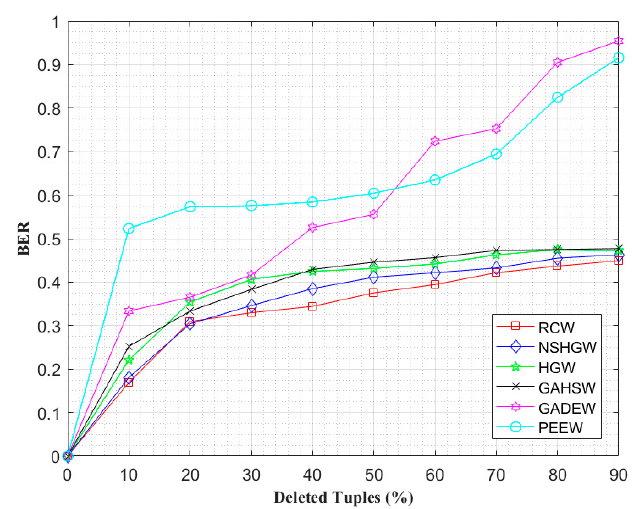
Figure 4. Deletion attacks bit error rate (BER) comparison for RCW, NSHGW, HGW, Genetic Algorithm and Histogram Shifting Watermarking (GAHSW), prediction error extended watermarking (PEEW), and GADEW algorithms.